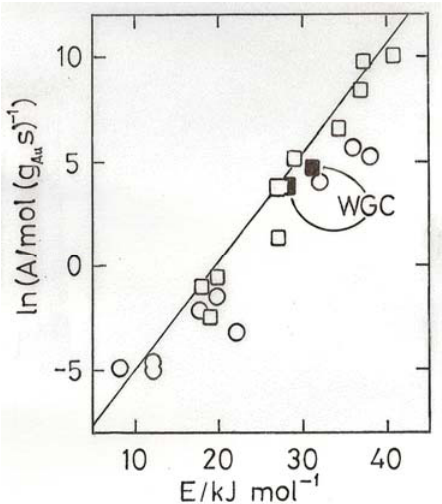
(squares) and Au/Al O 2 2 3 catalyst are 2